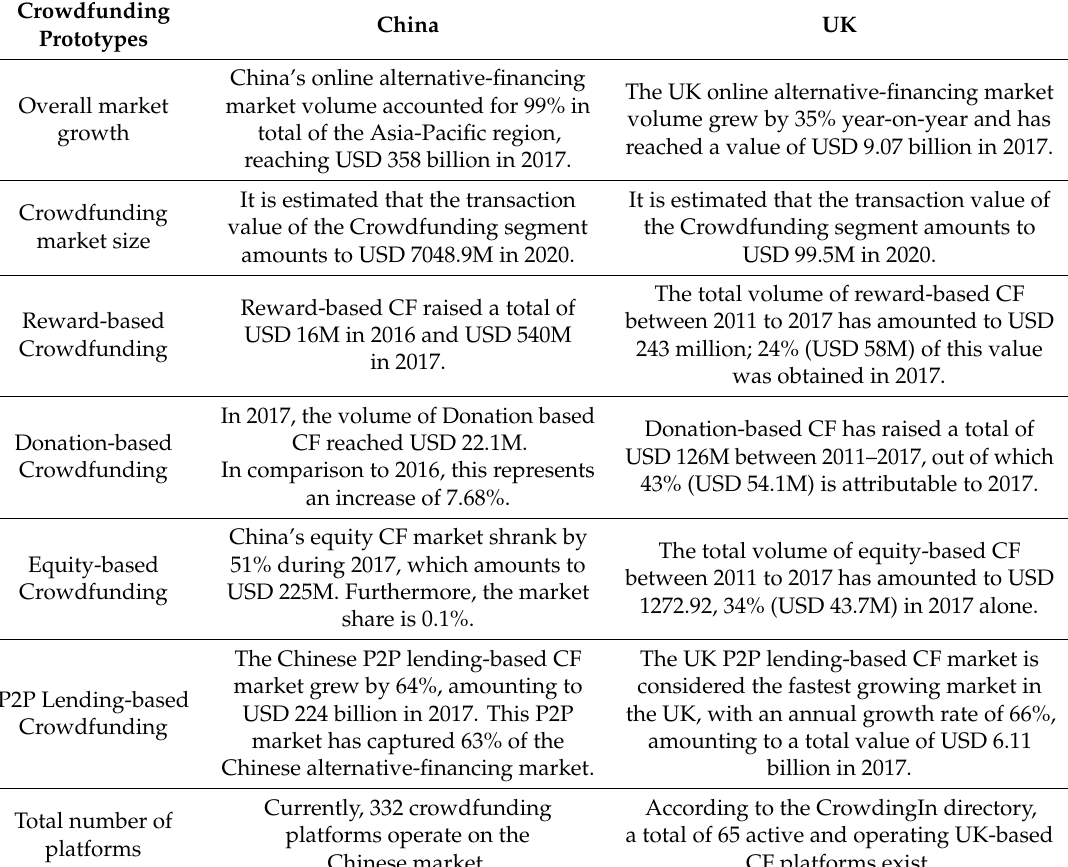
Table 1. China and UK market